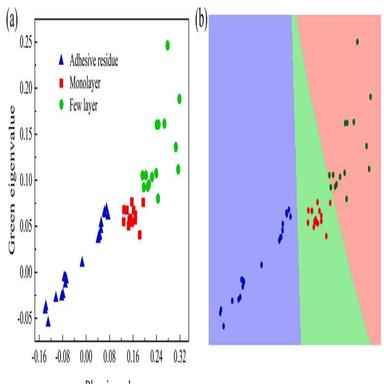
Feature data of suspected single ROI region. (a) Feature data distribution. (b) SVM training classification of feature data.